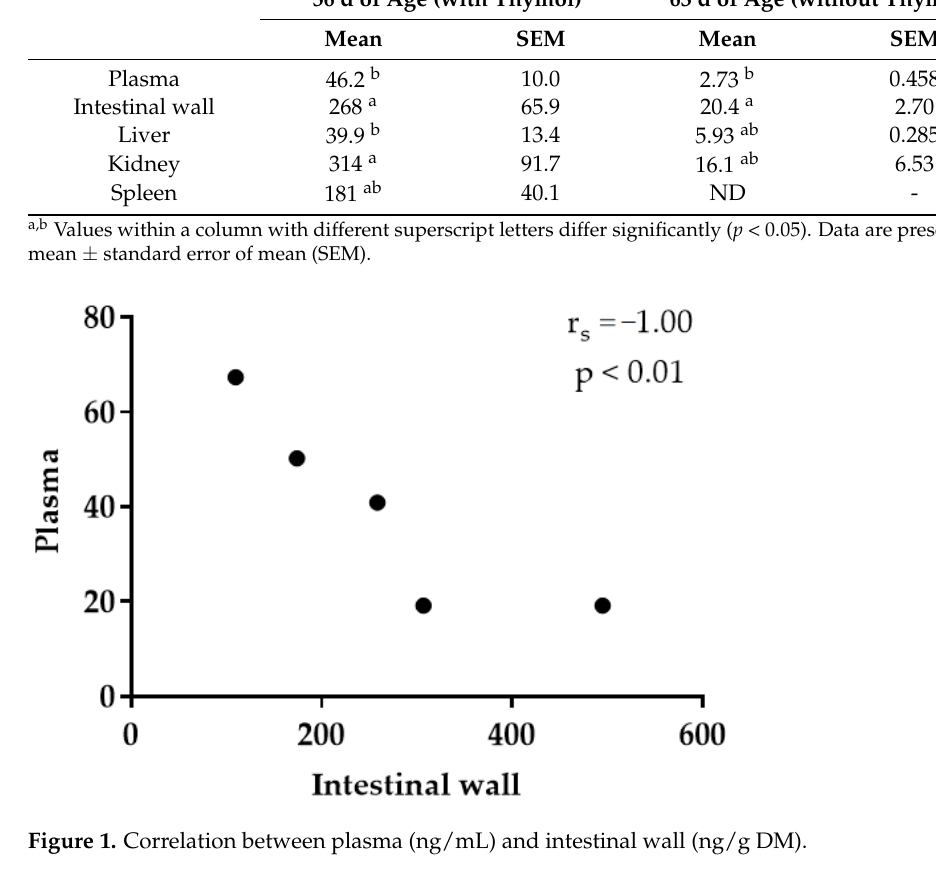
Table 2. Thymol content in plasma (ng/mL) and tissue (ng/g DM). 56 d of Age (with Thymol)